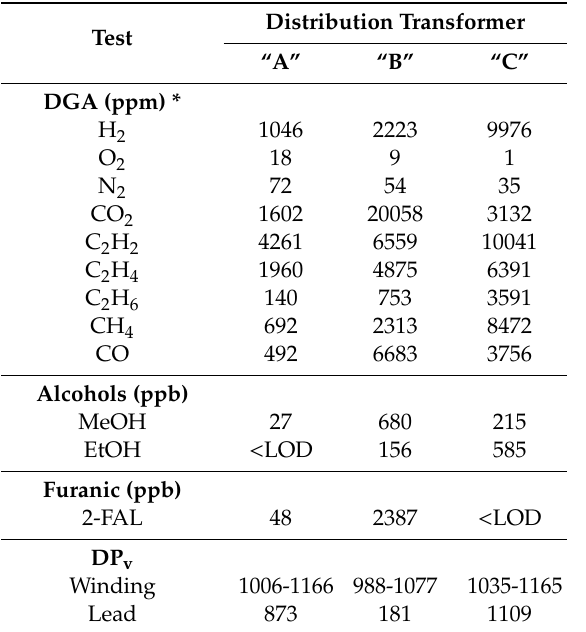
Table 4. Analysis of field-distribution transformers